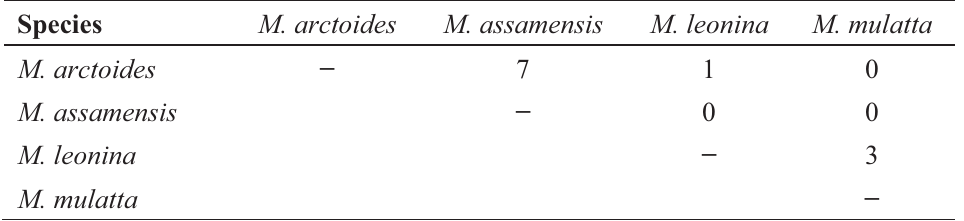
Table 4. Number of locations (GPS coordinate) that are common between the four species; obtained from the total occurrence points of each species used for the model ( cf. Table